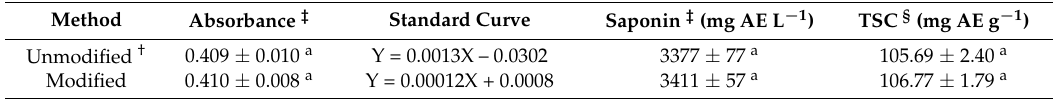
Table 6. Saponin values for the Gac seed kernel powder using ethanol as the extraction solvent and the unmodified and modified vanillin-sulphuric acid